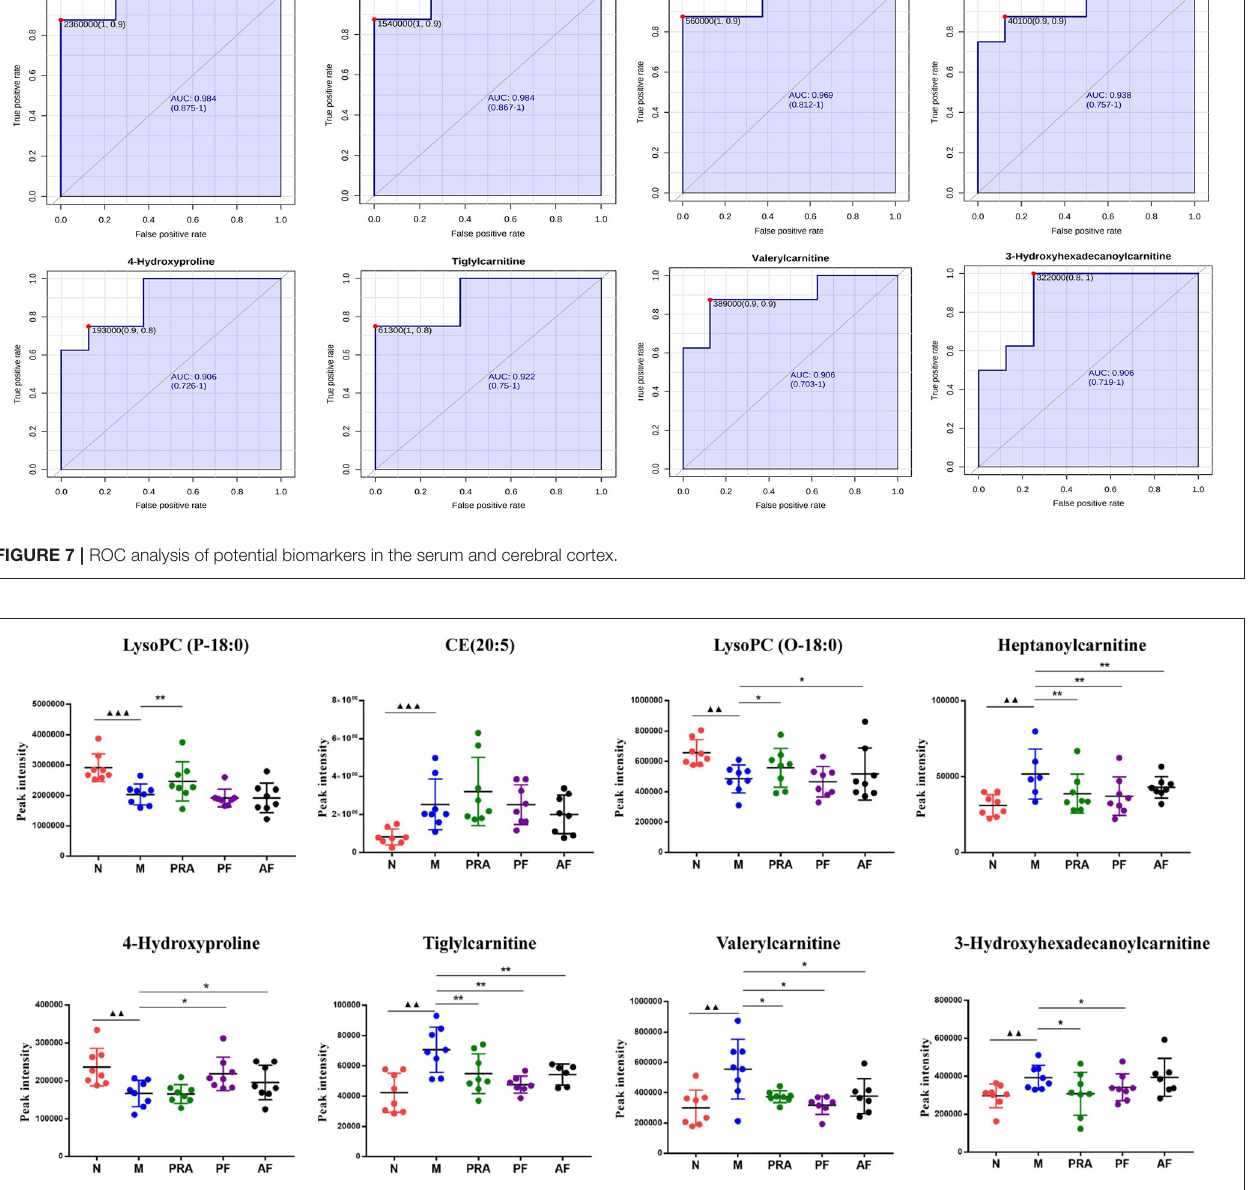
FIGURE 8 | Potential biomarkers in the serum and cerebral cortex. NNN P < 0.001, compared with the normal group; * P < 0.05, ** P < 0.01, compared with the model group. N, normal group; M, model group; PRA, Aqueous extract of Paeoniae Radix Alba group; PF, paeoniflorin group; AF, albiflorin group. NN p < 0.01, compared with the normal